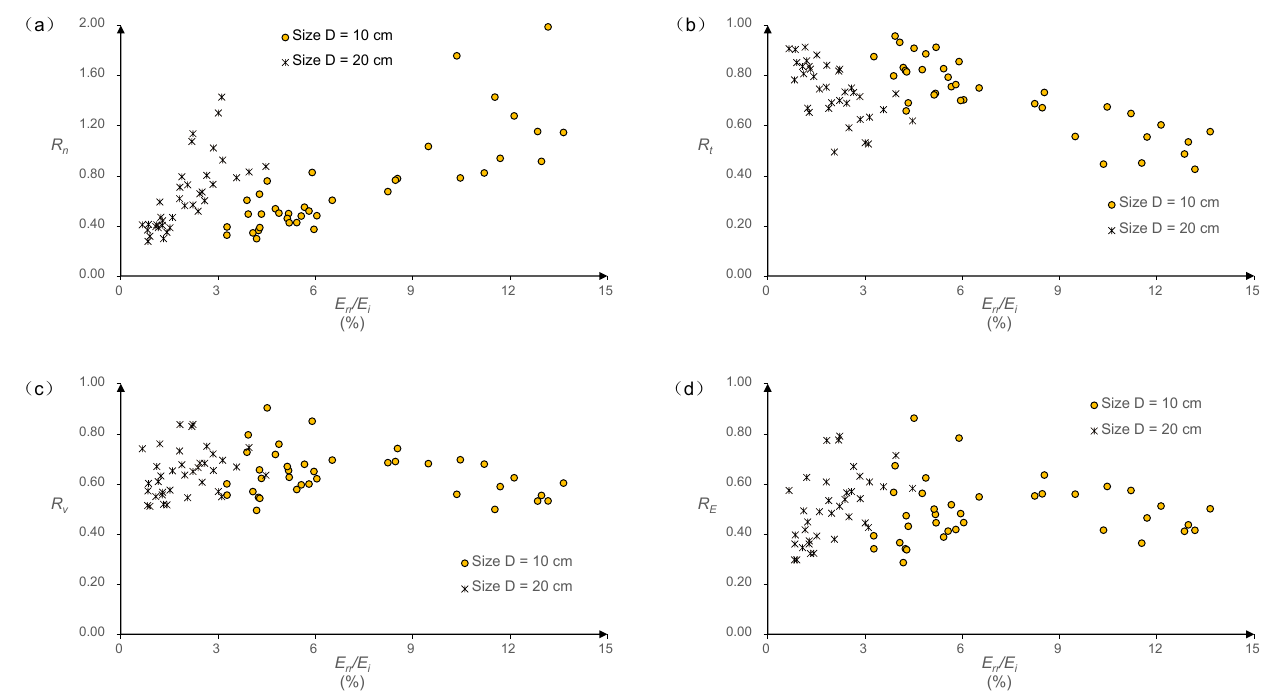
Figure 11. The variations of four coefficients of restitution, (a) the normal coefficient R n , (b) the tangential coefficient R t , (c) the kinematic coefficient R v and (d) the kinetic energy coefficient R E , with the ratio E rr /E i